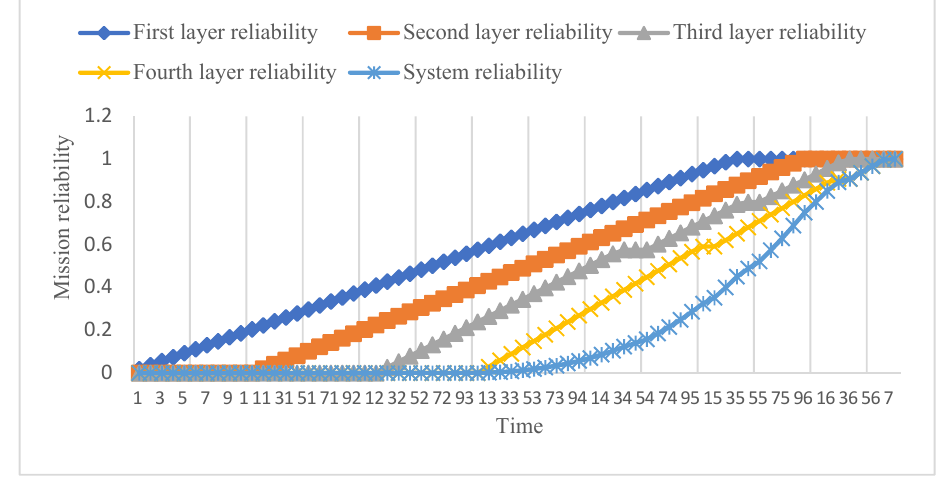
Figure 5. Mission reliability change.